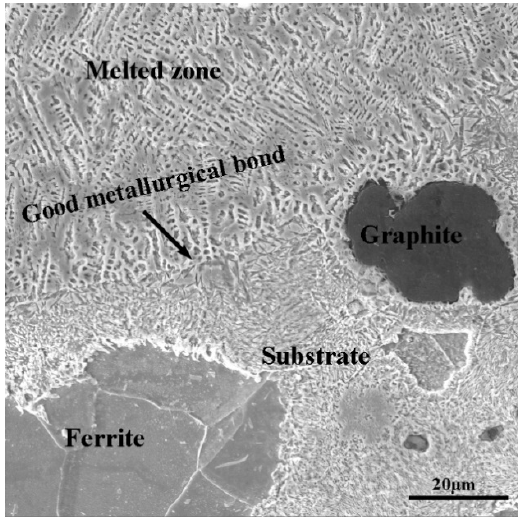
Figure 11. The interface between the melting zone and the substrate.